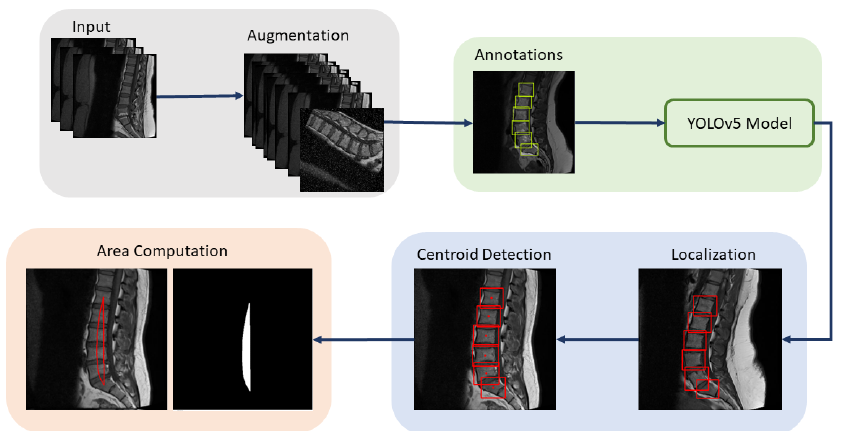
Figure 14. Region-area-based lumbar lordosis identification block diagram. The preprocessed dataset is passed through the localization network with its labels. Vertebrae are localized with very good confidence score and its centroids are calculated and joined together to form a region whose area can be calculated to find the severity of lumbar lordosis.